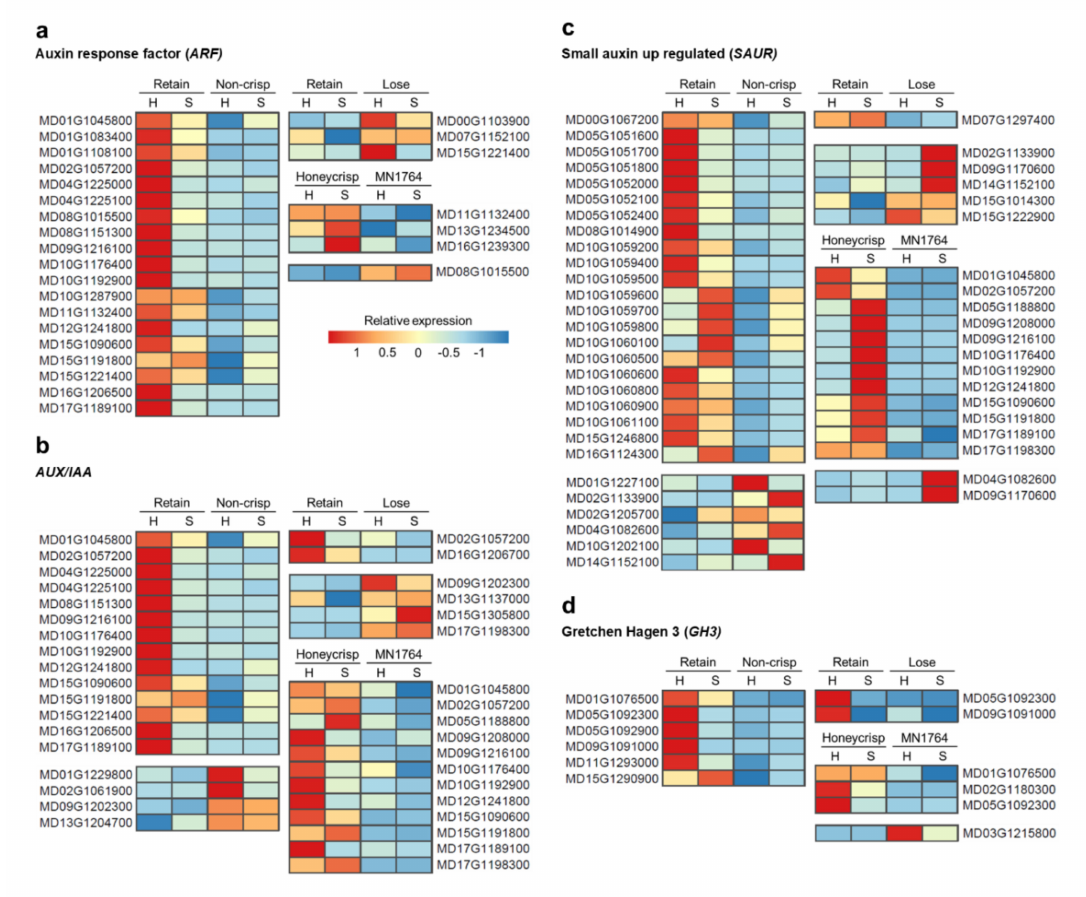
Figure 5. The expression patterns of the di ff erentially expressed genes (DEGs) involved in the auxin-activated signaling pathway. Two genes, ( a ) ARF and ( b ) AUX / IAA, that are associated with auxin signaling, and two genes, ( c ) SAUR , and ( d ) GH3, that are associated with auxin response were studied. The relative expression is the ratio of gene expression compared to the average. H = at harvest, and S = after 8-week cold